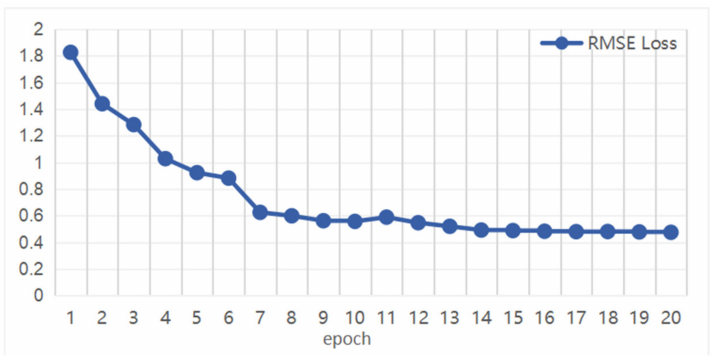
Figure 5. RMSE loss curve in policy network training. In this paper, we set epoch =